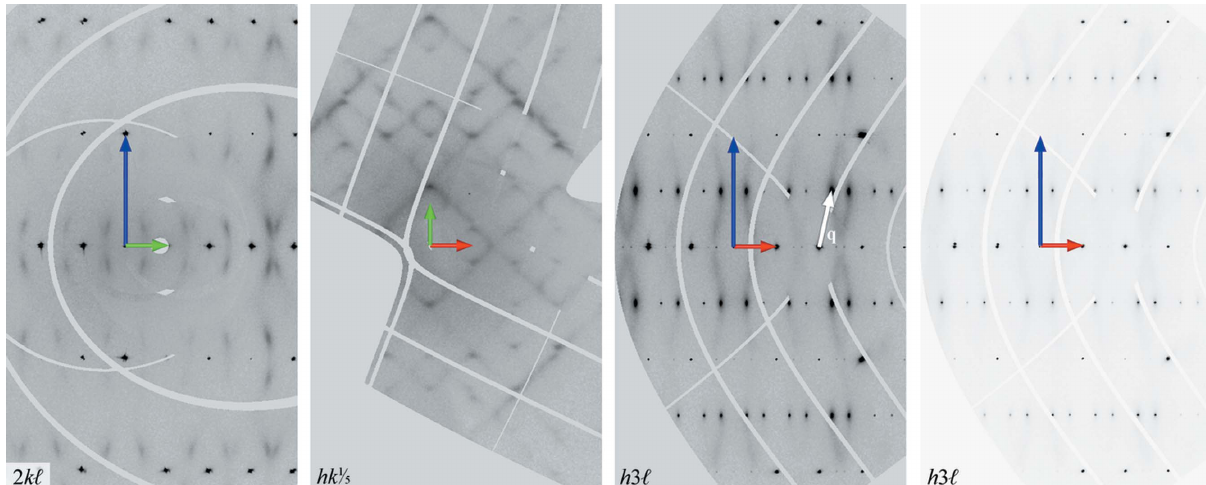
Figure 2 Portions of reciprocal space from the measurement of SA1 on ID28. The distorted grid of broad lines with zero intensity is due to the gaps between the detector modules. The reciprocal lattice vectors a *, b * and c * are shown as red, green and blue arrows, respectively, at the origin of each section. The h 3 l section is shown twice with two different greyscale settings (saturation limits are 4000 and 64 000 counts, respectively) to underline the sharpness of the satellite reflections on top of the diffuse discs. q is shown as a white arrow and indicates the similarity between the direction of q and the orientation of the diffuse streaks in sections perpendicular to b